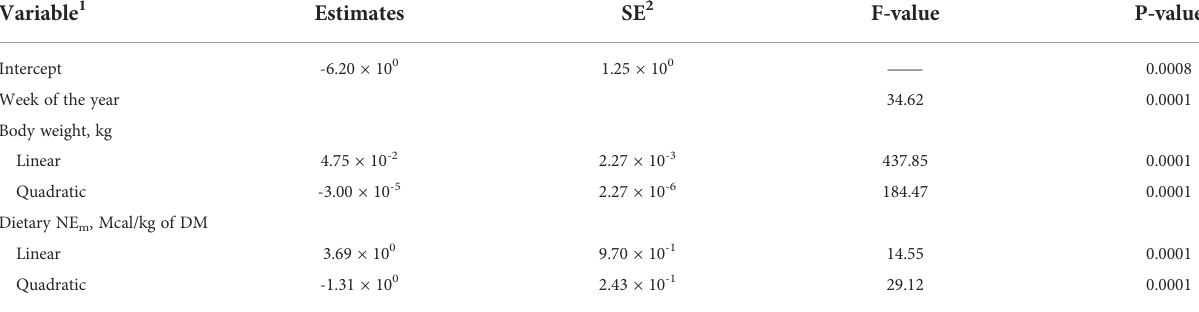
TABLE 3 Variables in the base model using restricted maximum likelihood estimation method (REML).